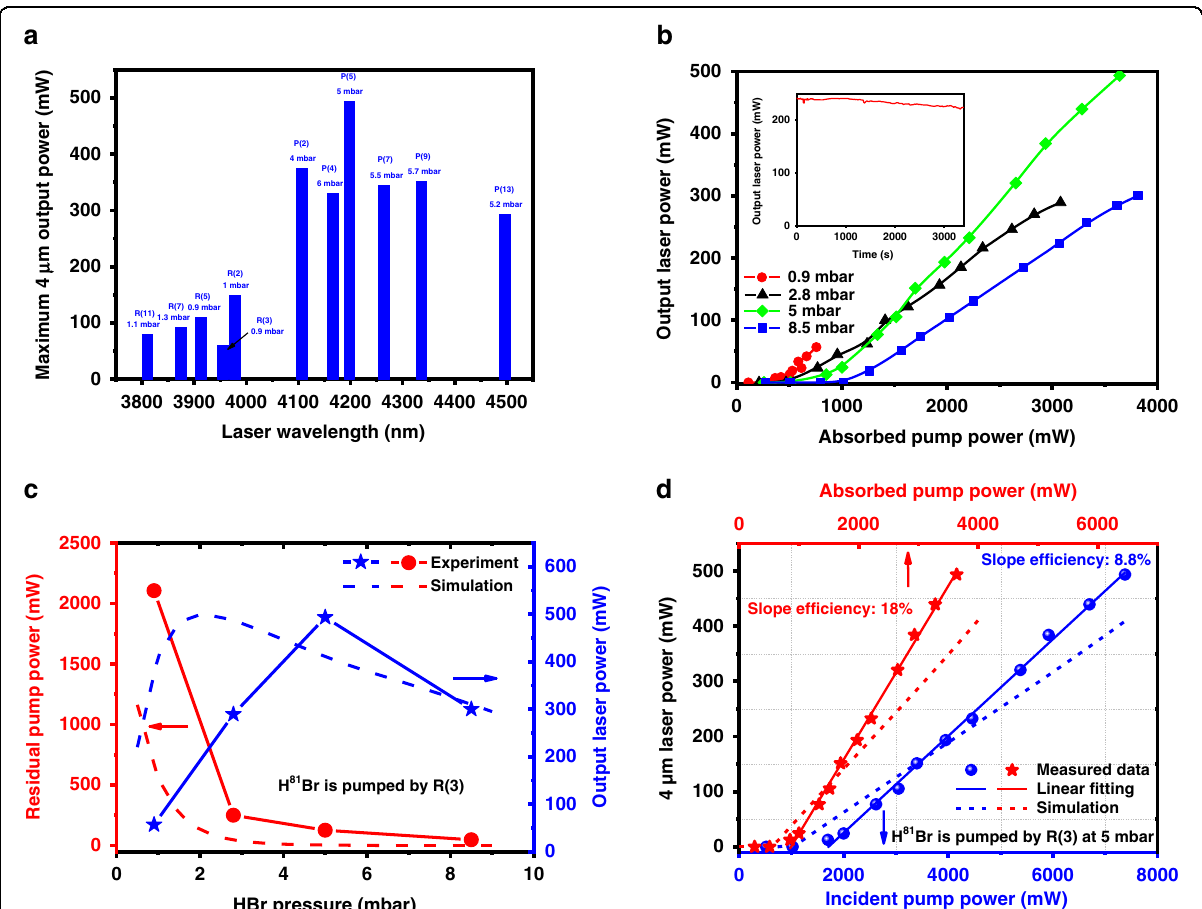
Fig. 6 Measured mid-IR laser power properties. a Measured maximum output laser power of eleven laser transitions with appropriate pressure. b Measured output laser power at different HBr gas pressures as a function of the absorbed pump power when pumped by the R(3) absorption line of the H 81 Br isotope; inset: the stability of laser output with time, measured at 5 mbar in near 1 h. c Measured and simulated maximum output laser power and residual pump power as a function of HBr pressure when pumped by the R(3) absorption line at an incident pump power of approximately 7.5 W. Solid lines with points are measured data and dashed lines with points are simulated results. d Measured and simulated output laser power when pumped by the R(3) absorption line at the optimum pressure of 5 mbar as a function of incident pump power and absorbed pump power. The points are measured data. The solid lines are linear fi tting of measured data and the dashed lines are simulated